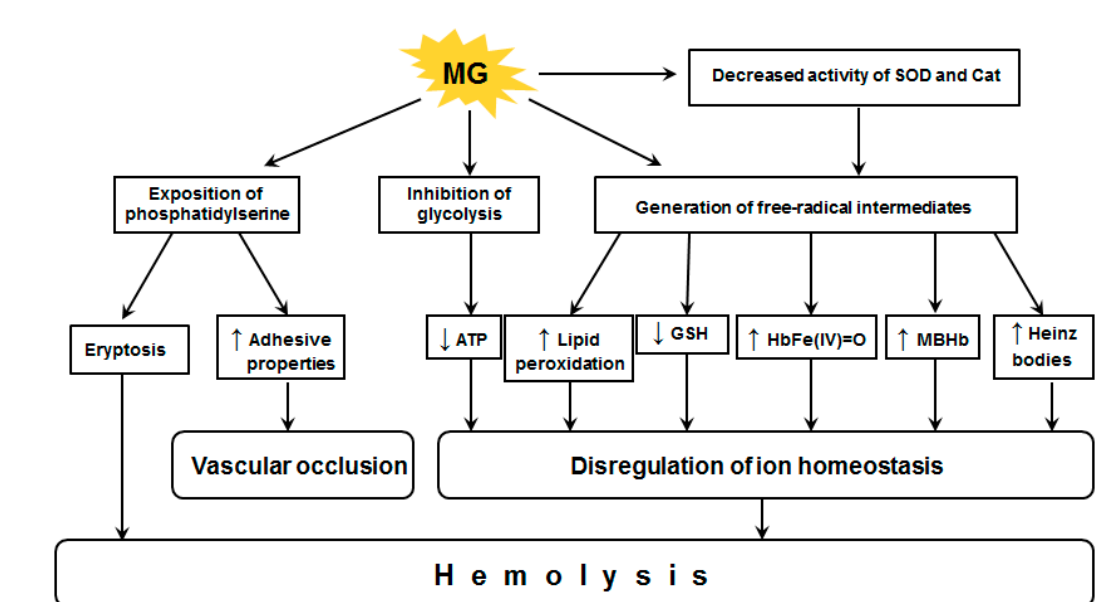
Figure 4. Pathological effects caused by MG action on red blood cells. Cat—catalase, GSH—reduced glutathione, MBHb—membrane-bound Hb; SOD—superoxide dismutase. The arrows ↑ and ↓ in frames indicate an increase and decrease in the indicators, respectively.